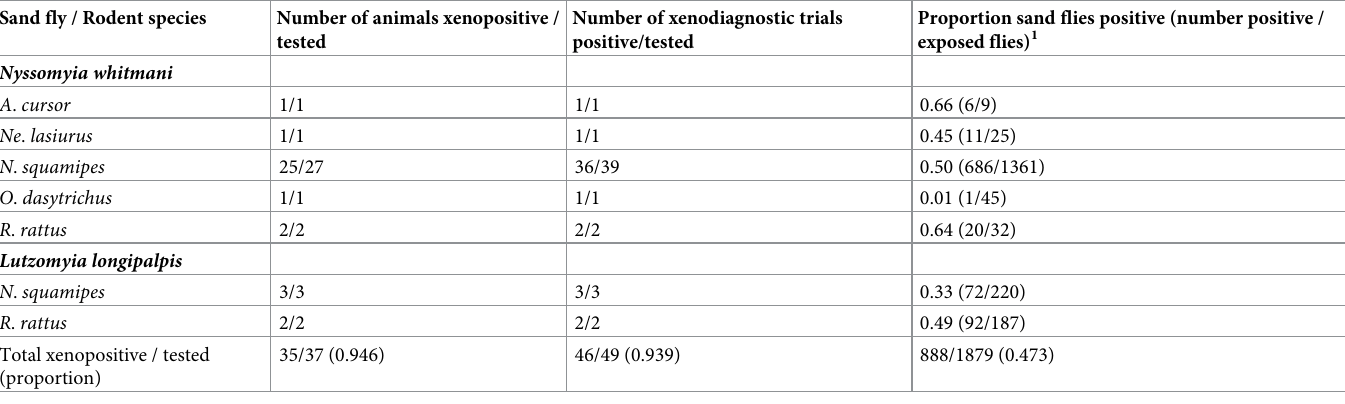
Table 7. Infectiousness of free-ranging wild rodents to wild caught Ny . whitmani sand flies, or to laboratory-bred Lu . longipalpis , measured by xenodiagnosis. Sand fly / Rodent